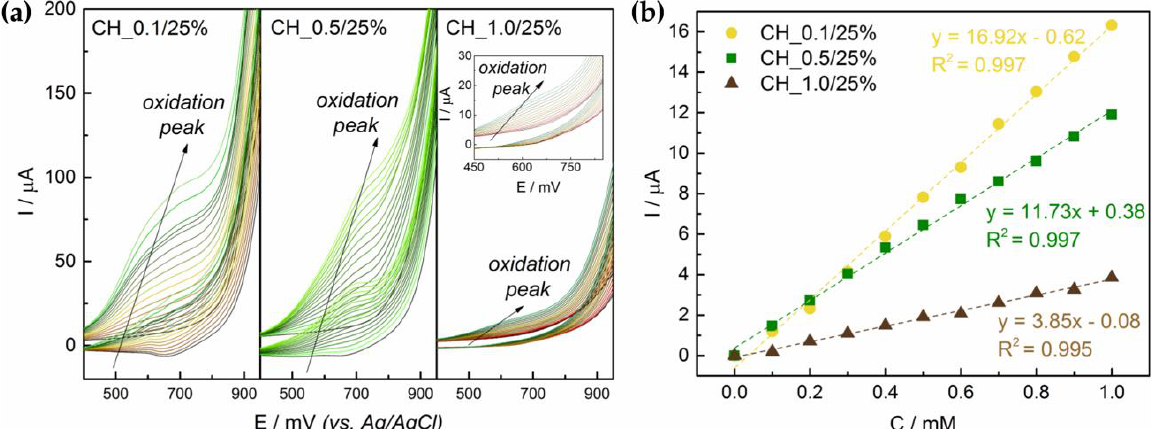
Figure 6. Electrochemical performance of the electrodes based on CH_0.1/25%, CH_0.5/25% and CH_1.0/25% suspensions: ( a ) voltammograms for glucose concentration range 0−1.5 mM; ( b ) regression lines glucose concentration versus generated current (step 0.1 mM).